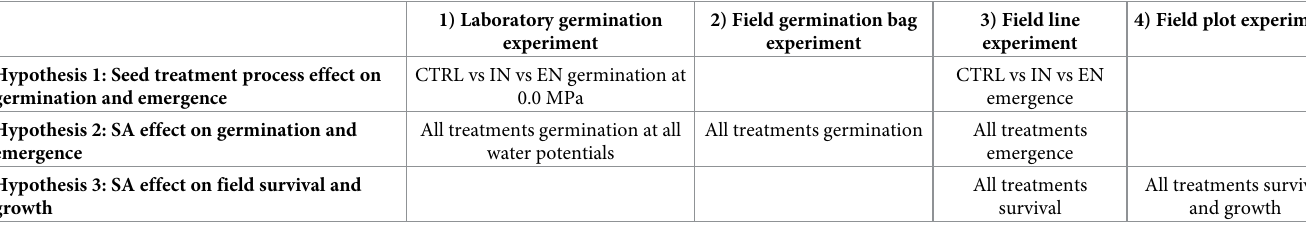
Table 1. Combination of hypotheses and experiments.